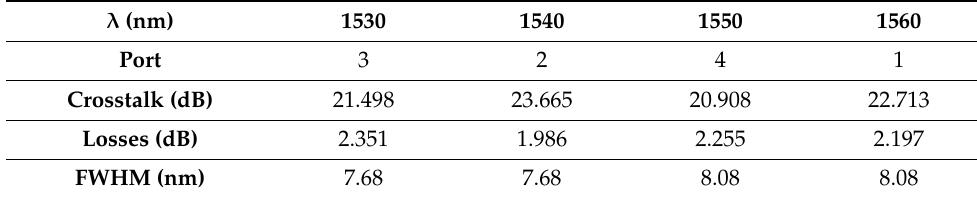
Table 2. Crosstalk, losses, and FWHM values for each port.